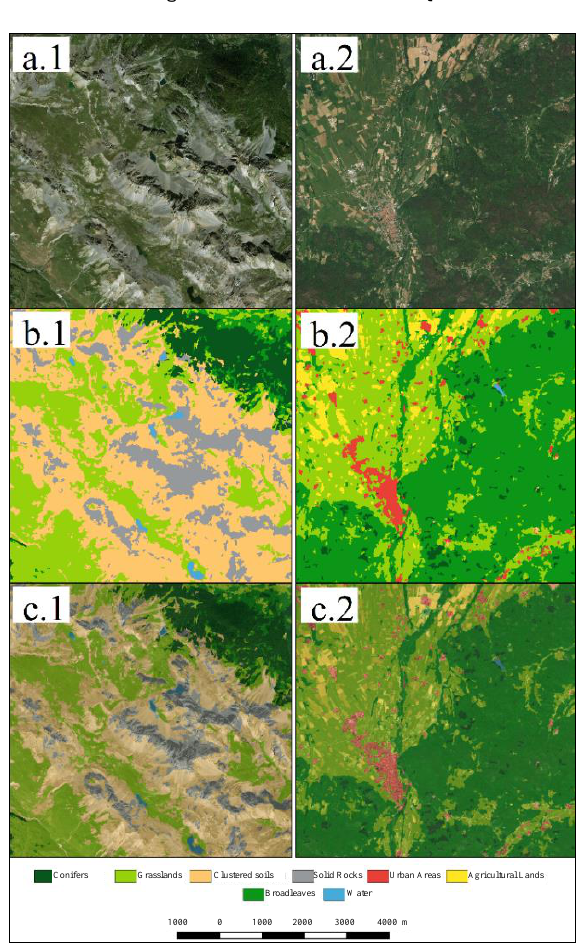
Figure 3. Some detail of the classification on tile in high- altitude mountainous areas ( left, scene 1) and lowlands (right, scene 2). Images a.1 and a.2 show the RGB orthophoto (Source: Bing Satellite); b.1 and b.2 shows the classification; c.1 and c.2 shows the overlapping of the orthophoto and the classification (low opacity).